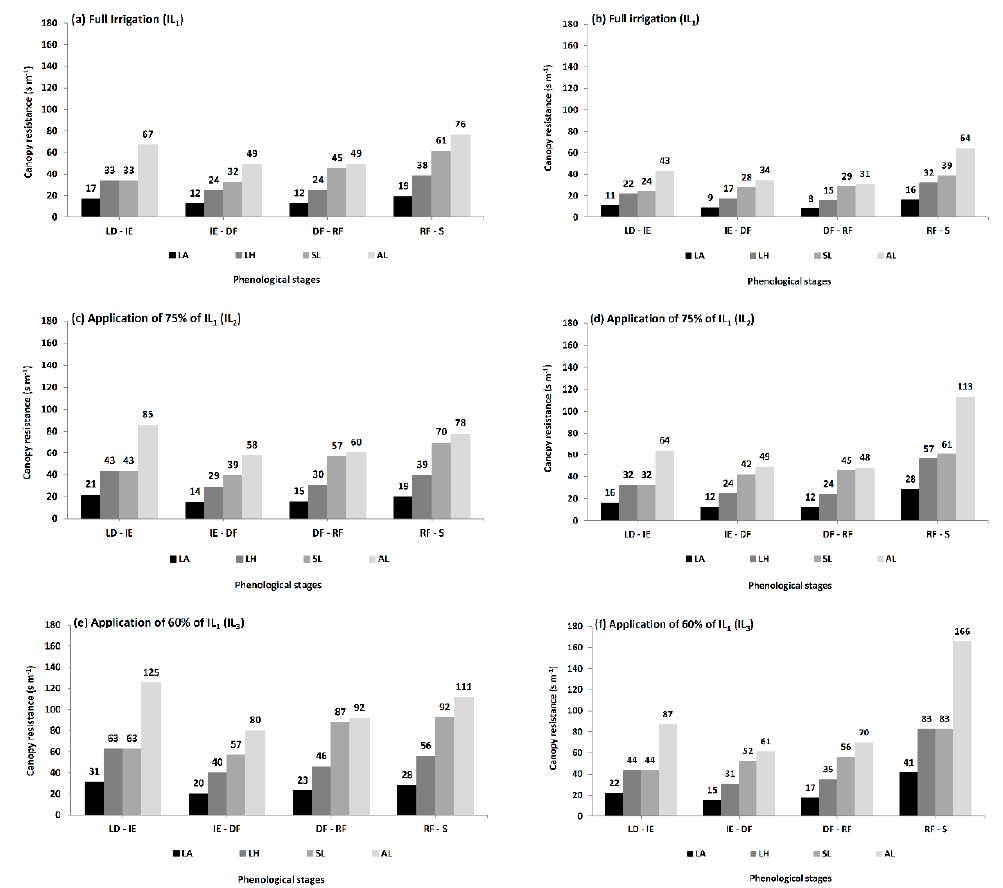
Figure 5. Midday average values (14:00–16:00) of canopy resistances ( r c ) during the main potato phenological periods under different irrigation levels (IL) for 2018/2019 ( a , c , e ) and 2019/2020 ( b , d , f ) evaluated seasons. LA and LH [63], SL [62], and AL [28] are the empirical models of r c used in this study. The potato phenological ranges LD-IE, IE-DF, DF-RF, and RF-S are leaf development–inflorescence emergence, inflorescence emergence–development of fruit, development of fruit–ipening of fruit and seed, and ripening of fruit and seed–finishing of senescence, respectively. These values were used to estimate crop potato evapotranspiration ( 𝐸𝑇 (cid:3030)(cid:3043) ). Estimation of 𝐸𝑇 (cid:3030)(cid:3043) Using LA and LH Approach ( 𝐸𝑇 (cid:3030)(cid:3043)(cid:3024)(cid:3017) ) and the Penman–Monteith equation using LA ( 𝐸𝑇 (cid:3030)(cid:3043)(cid:3013)(cid:3002) ) and LH ( 𝐸𝑇 (cid:3030)(cid:3043)(cid:3013)(cid:3009) ) canopy resistance ( 𝑟 (cid:3030) ) approaches for the full irrigation ( 𝐼𝐿 (cid:2869) ) condition during the 2018/2019 and 2019/2020 seasons are shown in Figure 6. The 𝐸𝑇 (cid:3030)(cid:3043)(cid:3013)(cid:3002) and 𝐸𝑇 (cid:3030)(cid:3043)(cid:3013)(cid:3009) overestimated 0.6 and underestimated 11% compared to 𝐸𝑇 (cid:3030)(cid:3043)(cid:3024)(cid:3017) for both seasons, respectively (Figure 6a,b).